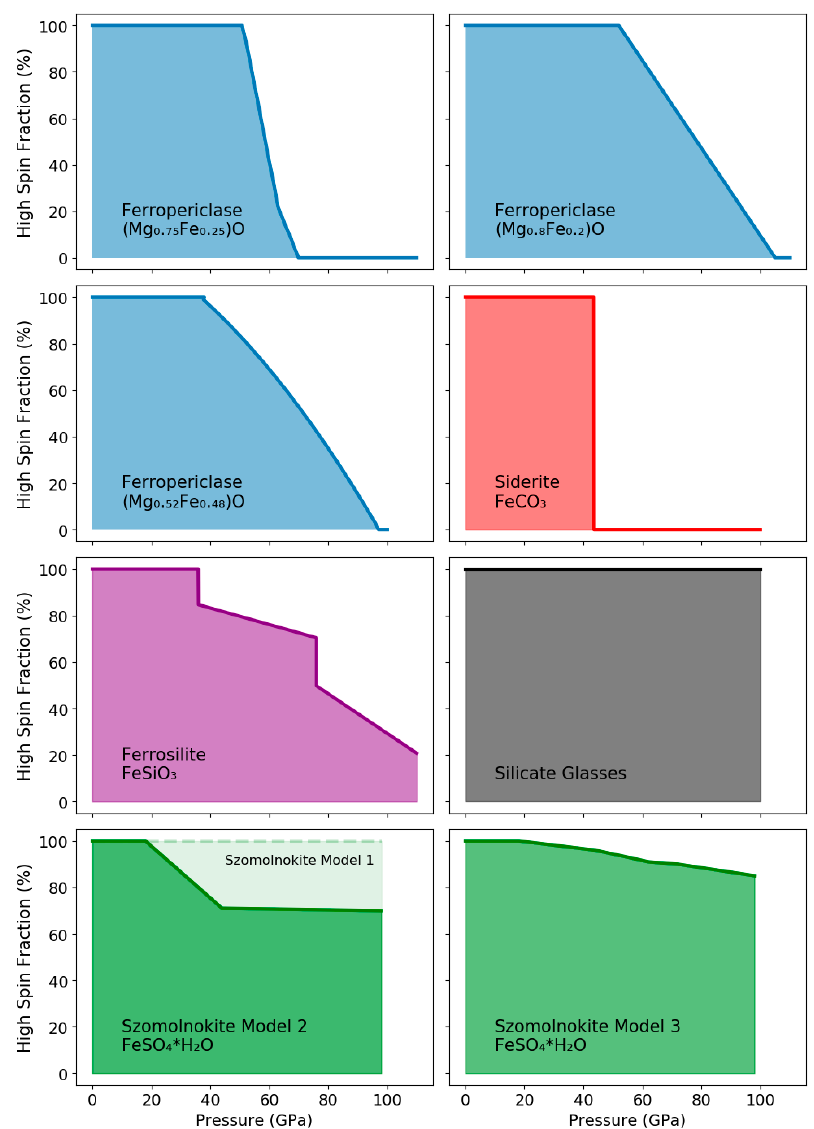
Figure 5. Schematic comparison of the fraction of high-spin ferrous iron (relative to low-spin ferrous iron) as a function of pressure at 300 K in various Fe 2+ -bearing phases: (Mg 0.75 Fe 0.25 )O ferropericlase, [31] , (Mg 0.8 Fe 0.2 )O ferropericlase [32] , (Mg 0.52 Fe 0.48 )O ferropericlase [29] , FeCO 3 siderite [30] , FeSiO 3 ferrosilite [27], basaltic and rhyolitic glasses [24], and FeSO 4 · H 2 O szomolnokite (this study). For szomolnokite, we include Model 2 (where site 3 undergoes a high- to low-spin transition) and Model 3 (where a fifth low-spin site gradually increases its weight fraction over a broad range of pressures). Model 1 is shown in the background of Model 2, exhibiting no spin transition over the pressure range investigated.